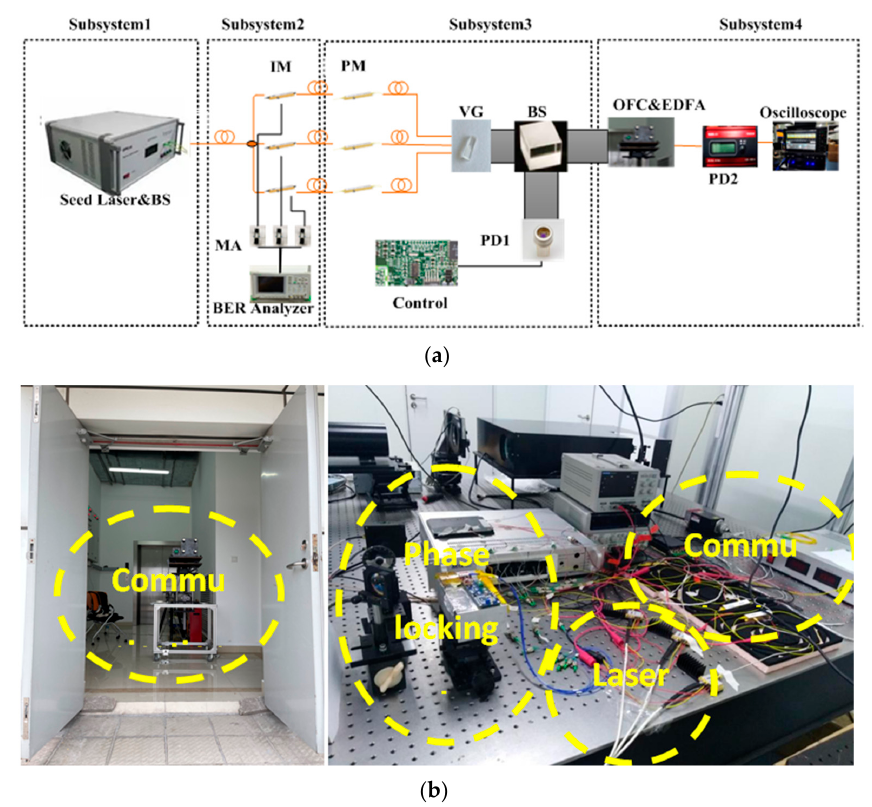
Figure 4. Diagram of the experimental device of the three-channel fiber laser-phased array multiplex communication system. ( a ) Set-up of the experiment; ( b ) experimental images.